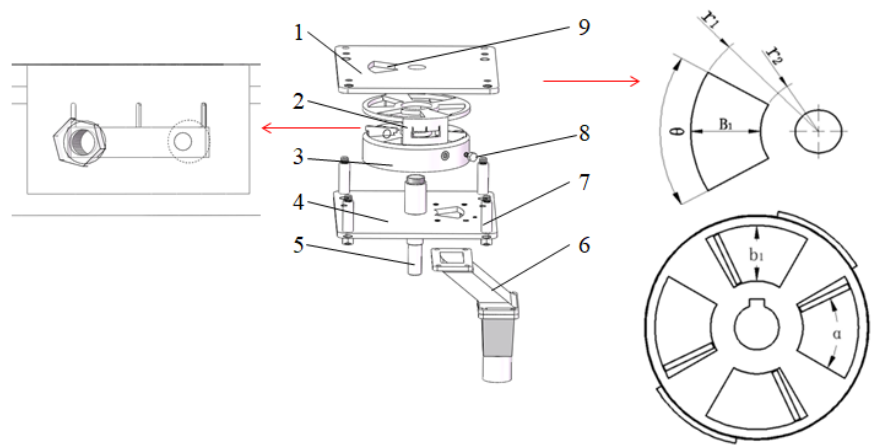
Figure 3. Structure of vertical variable cavity fertilizer drainer. 1. The upper board; 2. Cavity regu- lator; 3. Fertilizer disk; 4. The bottom board; 5. Rotary shaft; 6. Fertilizer pipe; 7. Support column; 8. Set screw; 9. The filling orifice of fertilizer disk. Note: B 1 is the width of the fertilizer opening of the organic fertilizer box, in mm; r 1 is the outer radius of the filling orifice, in mm; r 2 is the inner radius of the filling orifice, in mm; θ is the maximum opening of the fertilizer disk, in °; b 1 is the width of the fertilizer opening of the organic fertilizer discharge disk, in mm; α is the opening degree of the fertilizer discharge tray, in °.